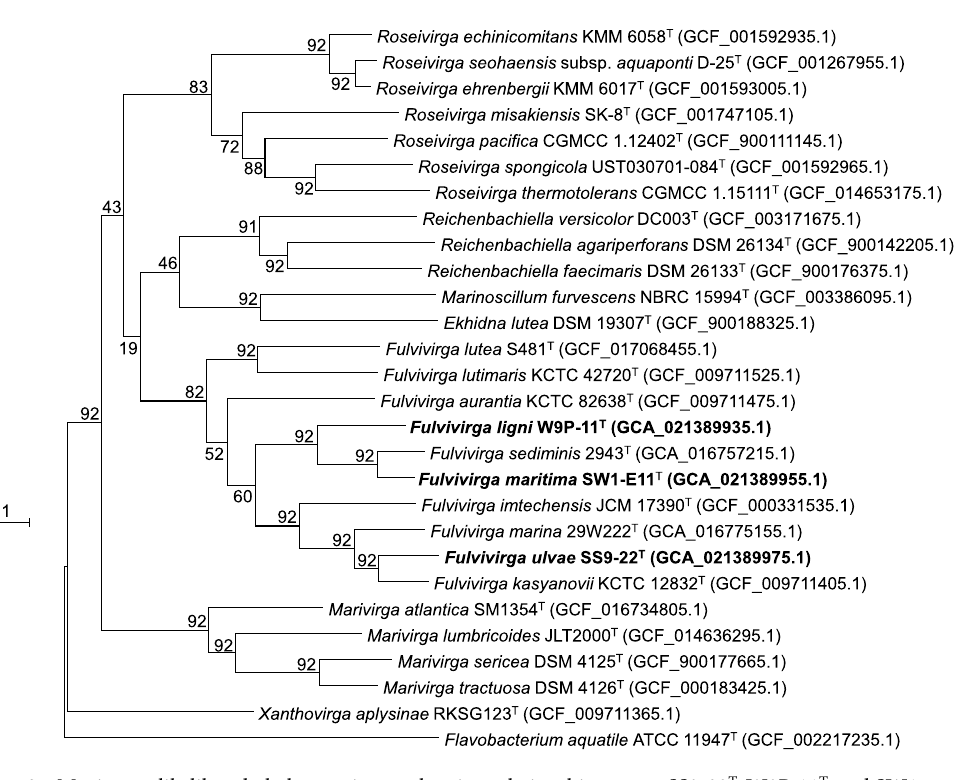
flexirubin-type pigment production. Negative for hydrolysis of Tween 80. The major fatty acid components are iso-C 15:0 , iso-C 17:0 3-OH, C 16:1 ω7c/C 16:1 ω6c, and C 16:1 ω5c. The type strain, W9P-11 T (= KCTC 72992 T = GDMCC 1.2803 T ), was isolated from a degraded wood. The genome contains one circular chromosome 6.52 Mb long. The G + C content is 38.95%, as calculated from whole-genome sequencing. Description of Fulvivirga maritima sp. nov.. Cells are gram-stain-negative, mesophilic, neutrophilic, and rod-shaped. They are positive for micro-aero- philic, catalase and oxidase activities. Colonies on MB agar are irregular, pale yellow, smooth, and dark yellow in